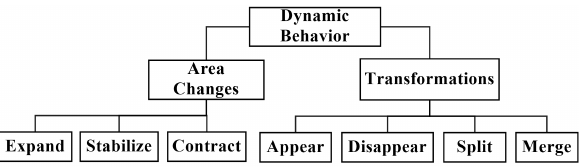
Figure 2: UHI behavior classification